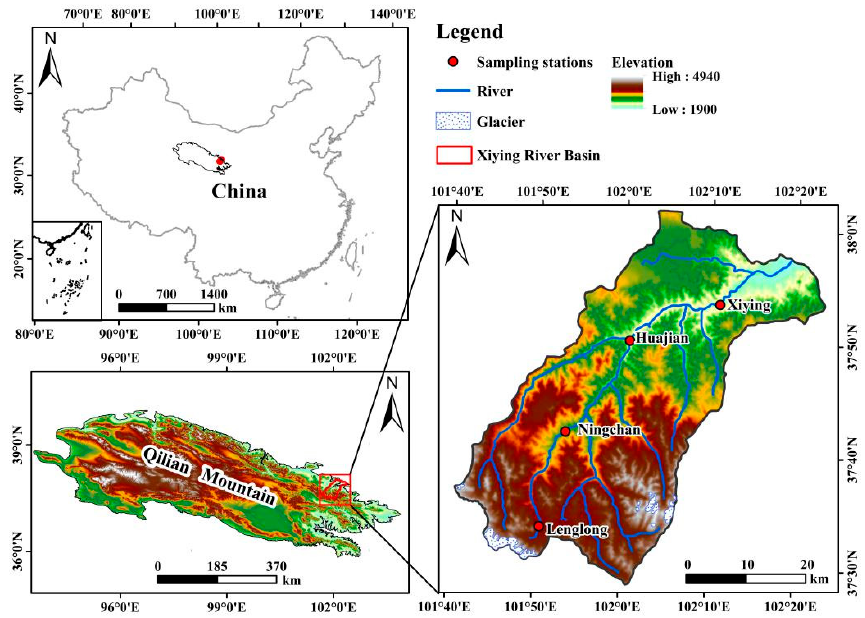
Figure 1. Overview of the study area and location of sampling points.